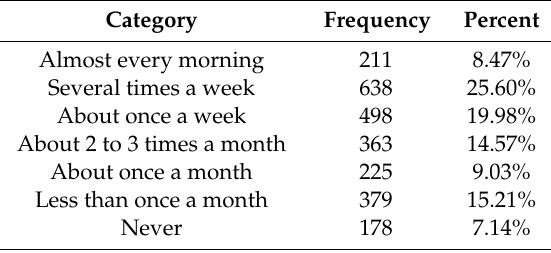
Table 1. Dream recall frequency ( n =